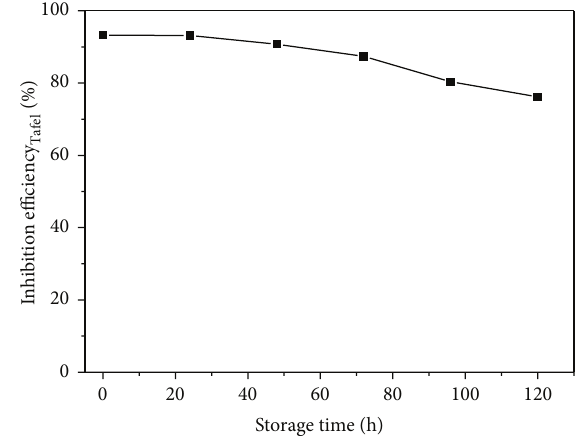
Figure 6: Relationships between inhibition efficiency and storage time from potentiodynamic polarization measurements for carbon steel in 0.5 M HCl with 160 mgL −1